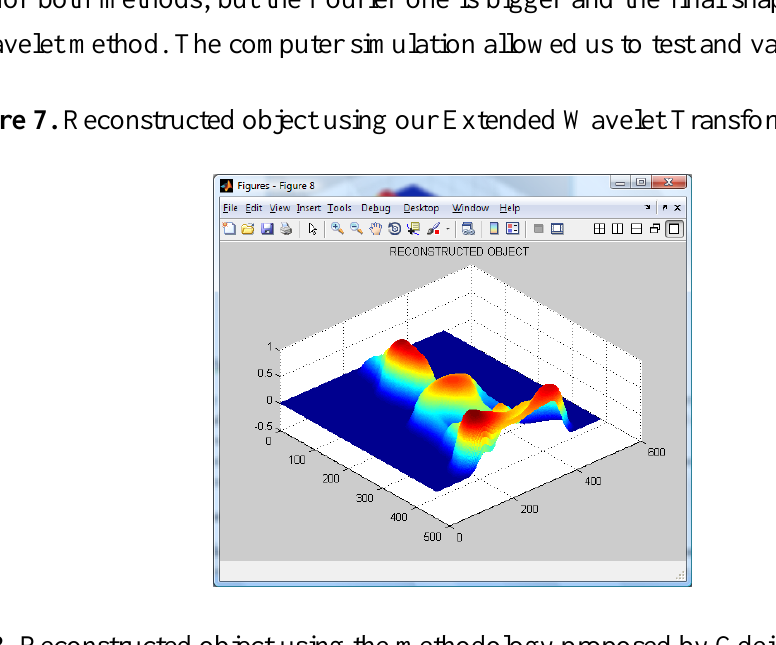
Figure 8. Reconstructed object using the methodology proposed by Gdeisat et al.